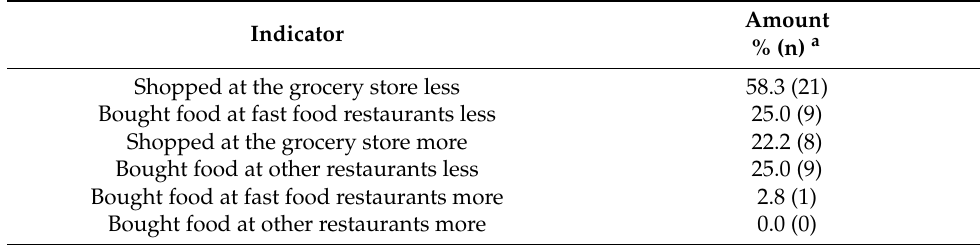
Table 5. Ways Meal Kits Impacted Other Food Purchasing